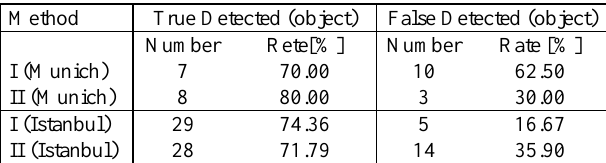
Table 4. Region-based change masks